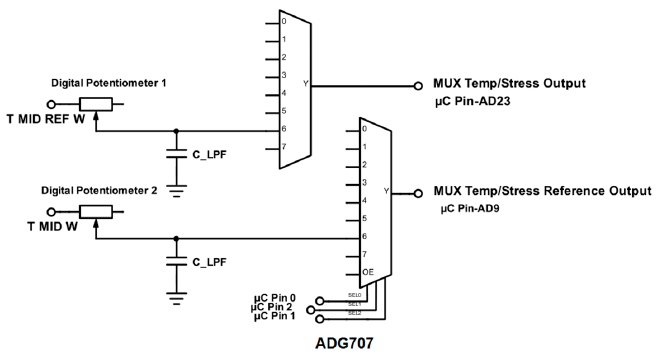
Figure 11. Circuit schematic showing a digitally controlled low-pass filter at each input stage for both sensor multiplexers.